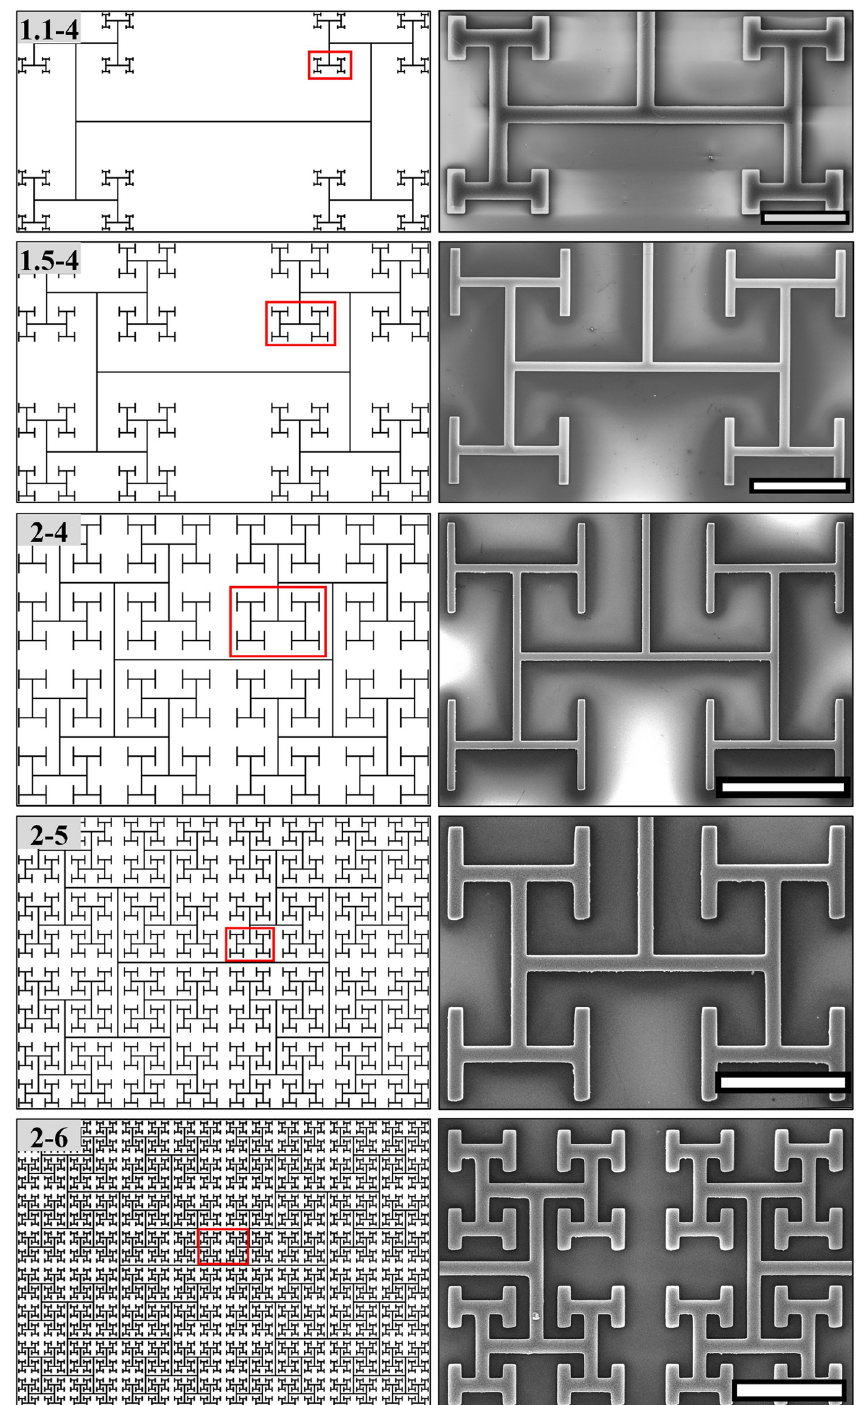
Fig 1. Schematic and scanning electron microscopy (SEM) images of fractal electrodes used in retinal cell culture experiments with different fractal dimensions D and repeating levels m . Left column from top to bottom: ( D = 1.1 and m = 4, labelled as 1.1–4), ( D = 1.5 and m = 4, labelled as 1.5–4), ( D = 2 and m = 4, labelled as 2–4), ( D = 2 and m = 5, labelled as 2–5), ( D = 2 and m = 6, labelled as 2–6). Right column: equivalent SEM image of the marked area in each electrode on the left column. The scale bars are 100, 200, 400, 200 and 200 μ m from top to bottom.